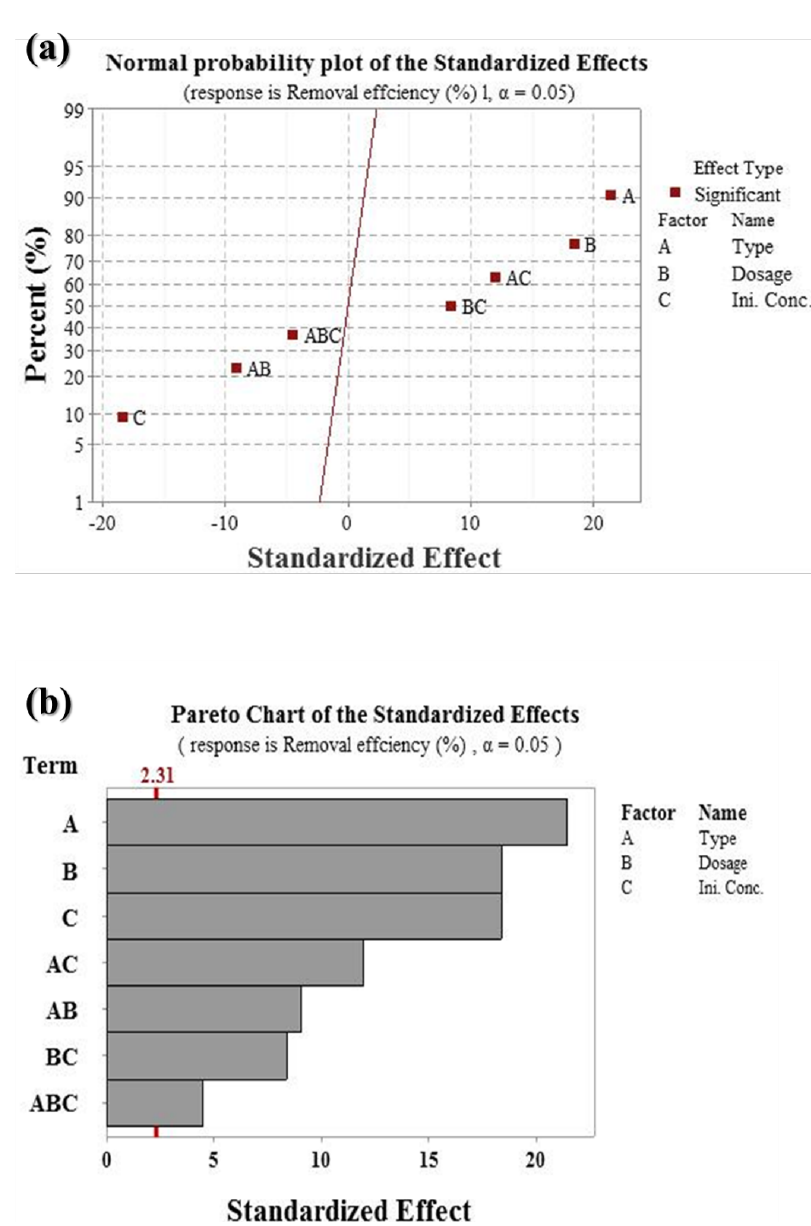
Figure 9. ( a ) Normal plot of the standardized effects; ( b ) Pareto chart of the standardized effects.